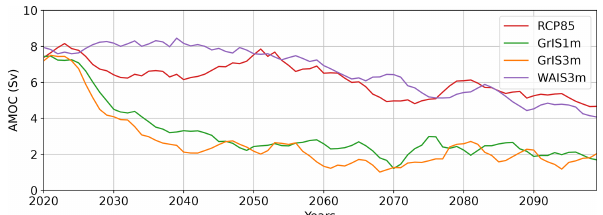
Figure 3. Simulated AMOC between 2020 and 2099 for different scenarios: RCP8.5 in red, GrIS1m in green, GrIS3m in orange and WAIS3m in purple. The AMOC index is derived from the maximum annual mean stream function at 30 ◦ N from Cheng et al.